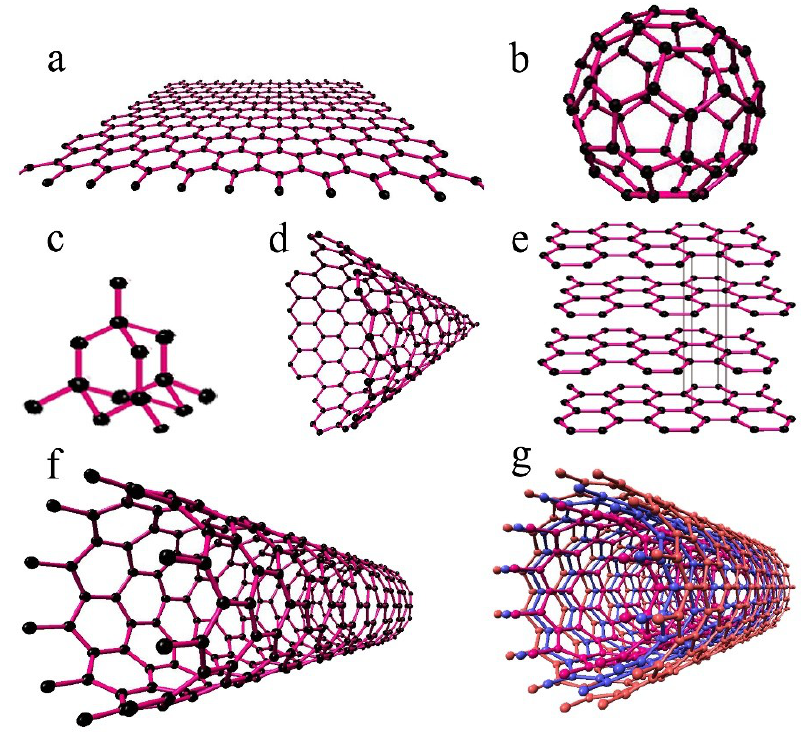
Figure 6. Some important carbonaceous structures, ( a ) Graphene, ( b ) Fullerene C 60 , ( c ) Diamond, ( d ) NanoCone, ( e ) Graphite, ( f ) Single-wall Carbon Nanotube, and ( g ) Multiwall Carbon